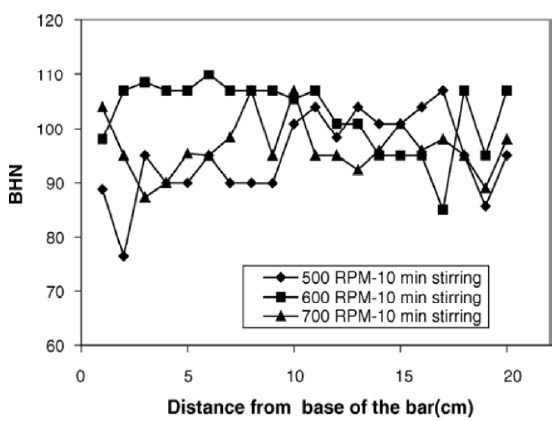
Fig. 1. Effect of stirring speed on hardness of Al– SiC MMC fabricated at 10 min stirring. Reprinted with permission from Balasivanandha Prabu,